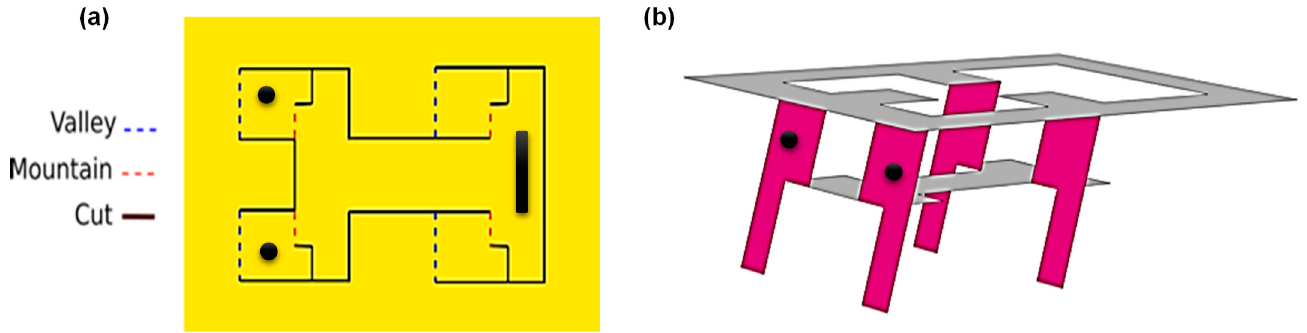
Figure 2. SLEM: ( a ) Top–down view of SLEM base with mountain and valley folds represented by dotted lines, cuts represented by continuous black lines (leg length 10 mm). IPMs (black circles) are attached to the front legs, and soft magnet stripes attach to the tail for increased anchoring (leg length 10 mm). ( b ) Three-dimensional (3D) simulation of SLEM in the pop-up configuration (leg length 14 mm). When the SLEM is under the influence of a magnetic field, the legs pop up, thus pushing the SLEM body/base upward and forward (leg length 10 mm).